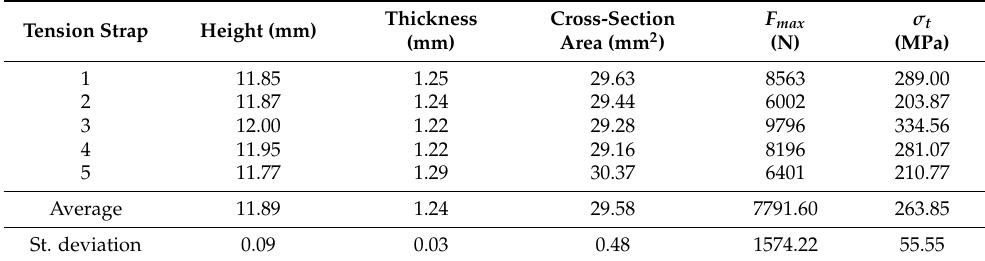
Table 3. Results of the tensile tests of the uncompressed 3D-printed CFRP preforms under quasi- static